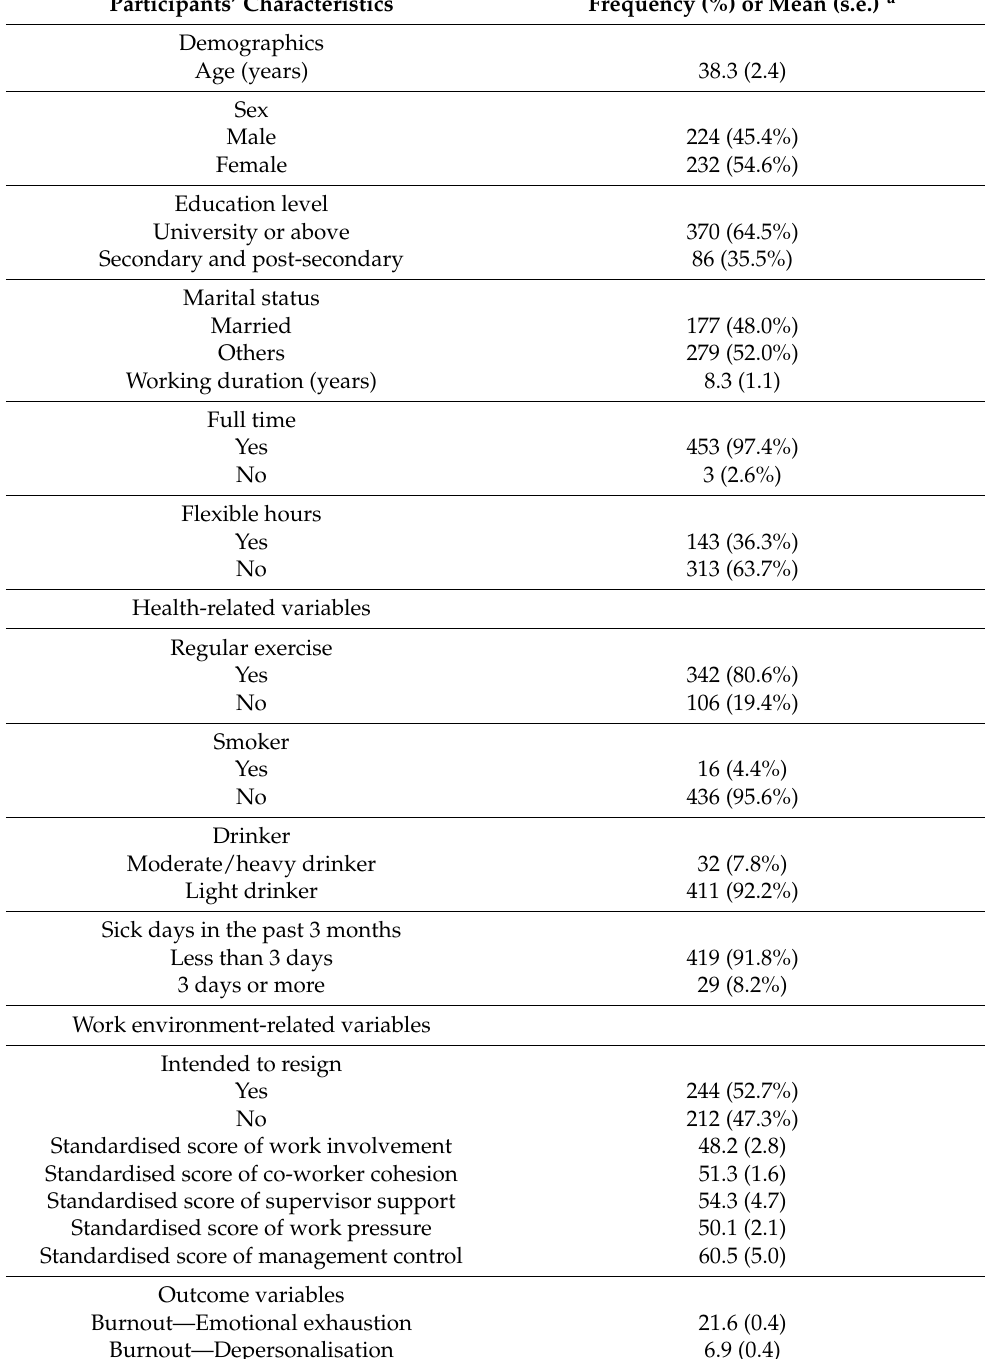
Table 1. Descriptive statistics on participants’ demographic and other variables (N =